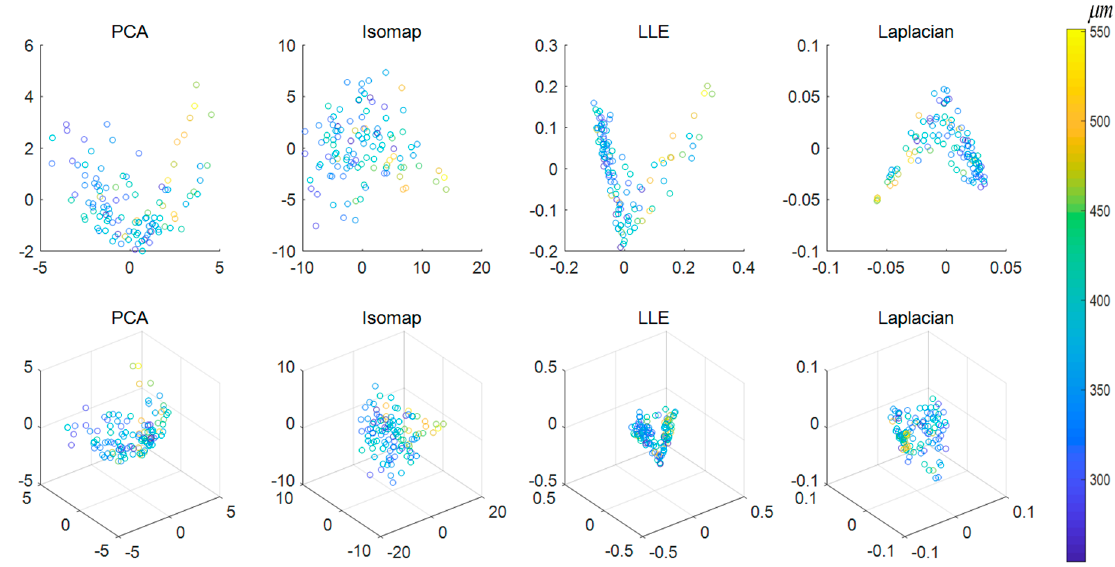
Figure 9. The 2D (top row) and 3D visualization (bottom row) of the width-labeled samples after dimensionality reduction.